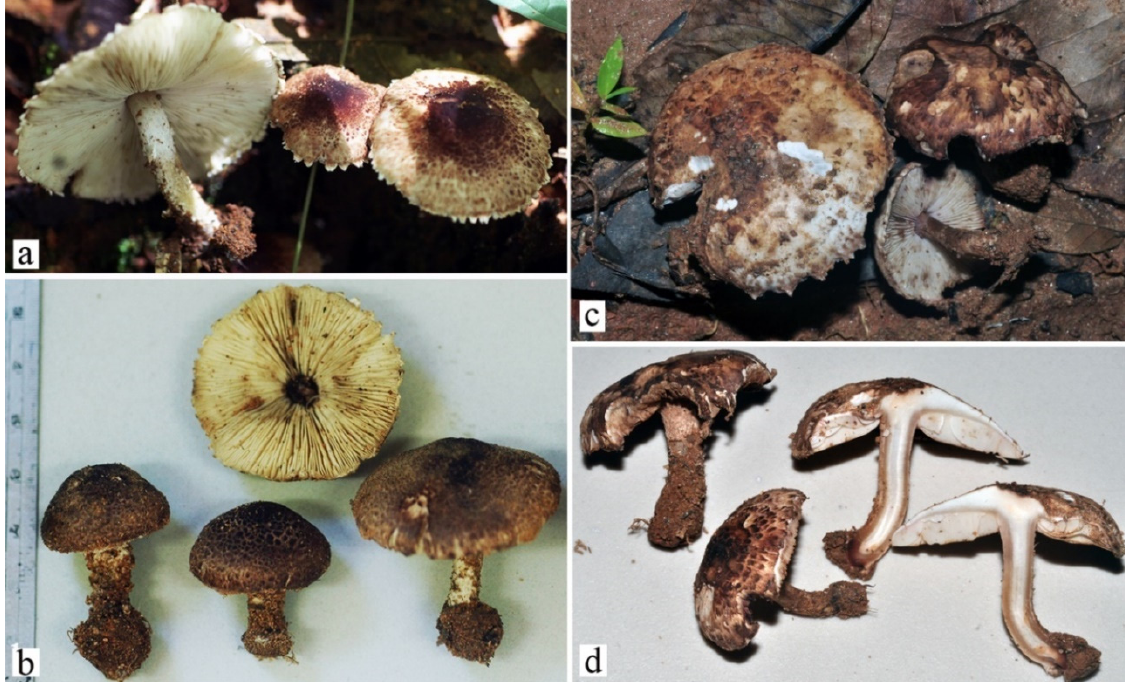
Figure 23. Fresh basidiomata of Pseudolepiota zangmui . ( a ) MFLU 10-0515. ( b ) MFLU 10-0518. ( c , d ) MFLU 192-355.